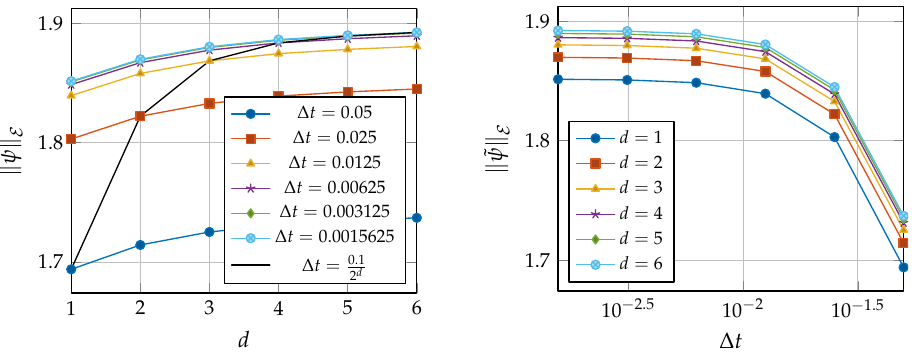
Figure 6. Squared space-time energy norm (60) of the approximated density on the straight scatterer versus increasing B-spline degree (left) and refined time discretization (right).